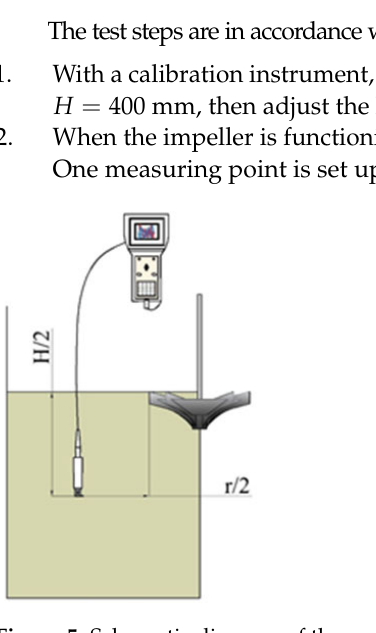
Figure 5. Schematic diagram of the aeration tank and impeller.